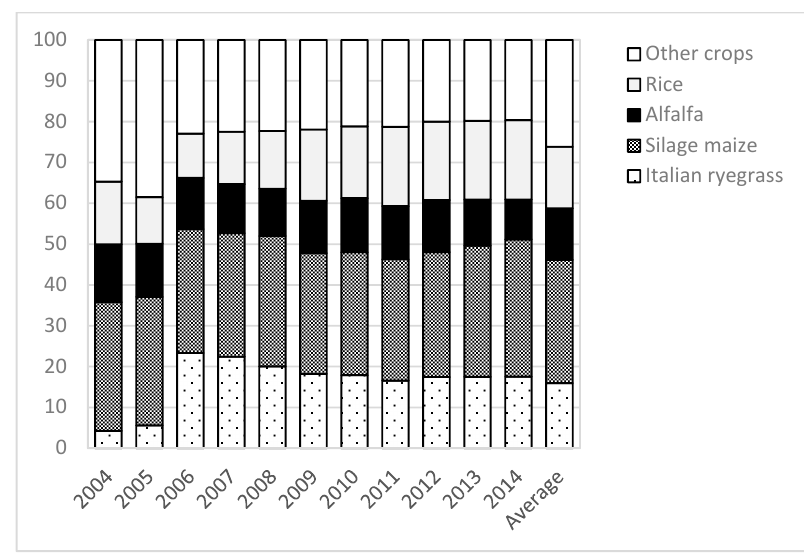
Figure 1. Percentage breakdown by crop type of the irrigated water areas assigned by the Oristanese CBI. Italian ryegrass is grown as an irrigated hay crop integrated into a double cropping system in the same areas occupied by silage maize.